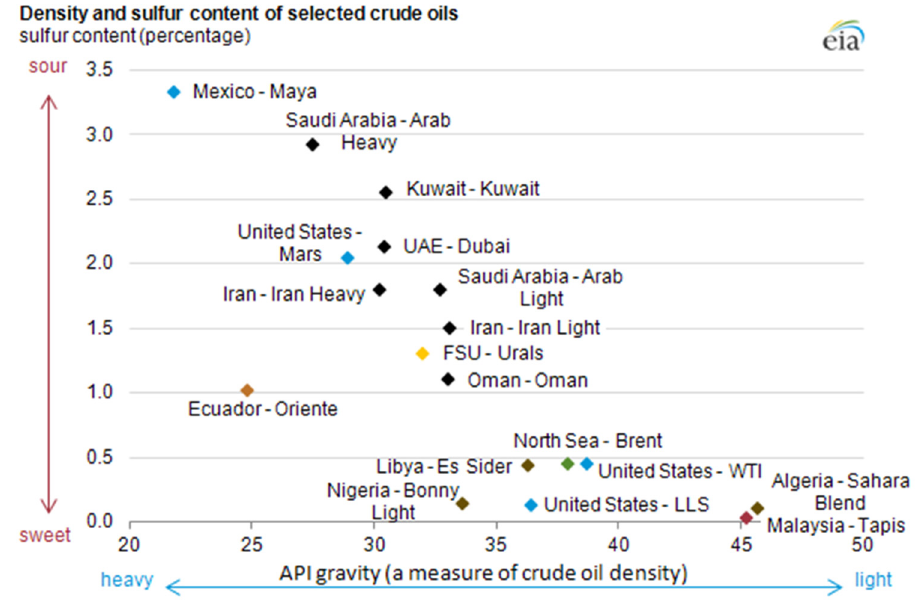
Figure 21. Density and sulfur content of selected crude oils.